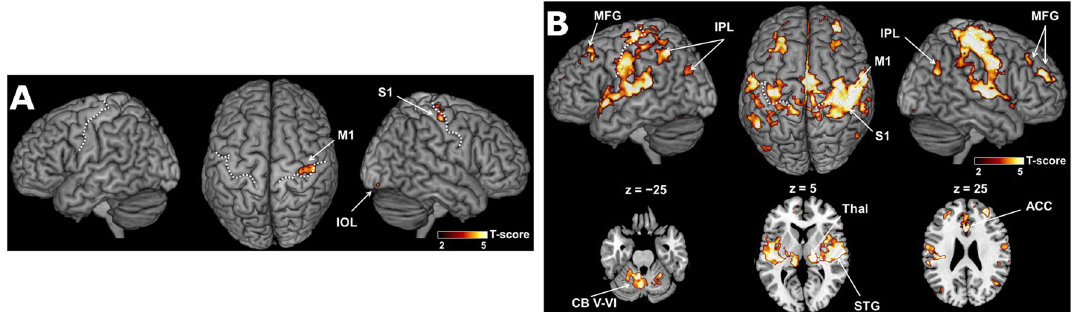
Figure 5. Learning related changes during execution and preparation. Linear increments in ( A ) execution- related and ( B ) preparation-related activity superimposed on the surface-rendered high-resolution magnetic resonance imaging of the template brain. The white dotted lines indicate the central sulcus. The level of statistical significance is set to p < 0.05, family-wise error corrected for multiple comparisons at the cluster-level. CB, cerebellum; IPL, inferior parietal lobule; MFG, middle frontal gyrus; S1, primary somatosensory cortex; M1, primary motor cortex; SMA, supplementary motor area; STG, superior temporal gyrus; Thal, thalamus; ACC, anterior cingulate